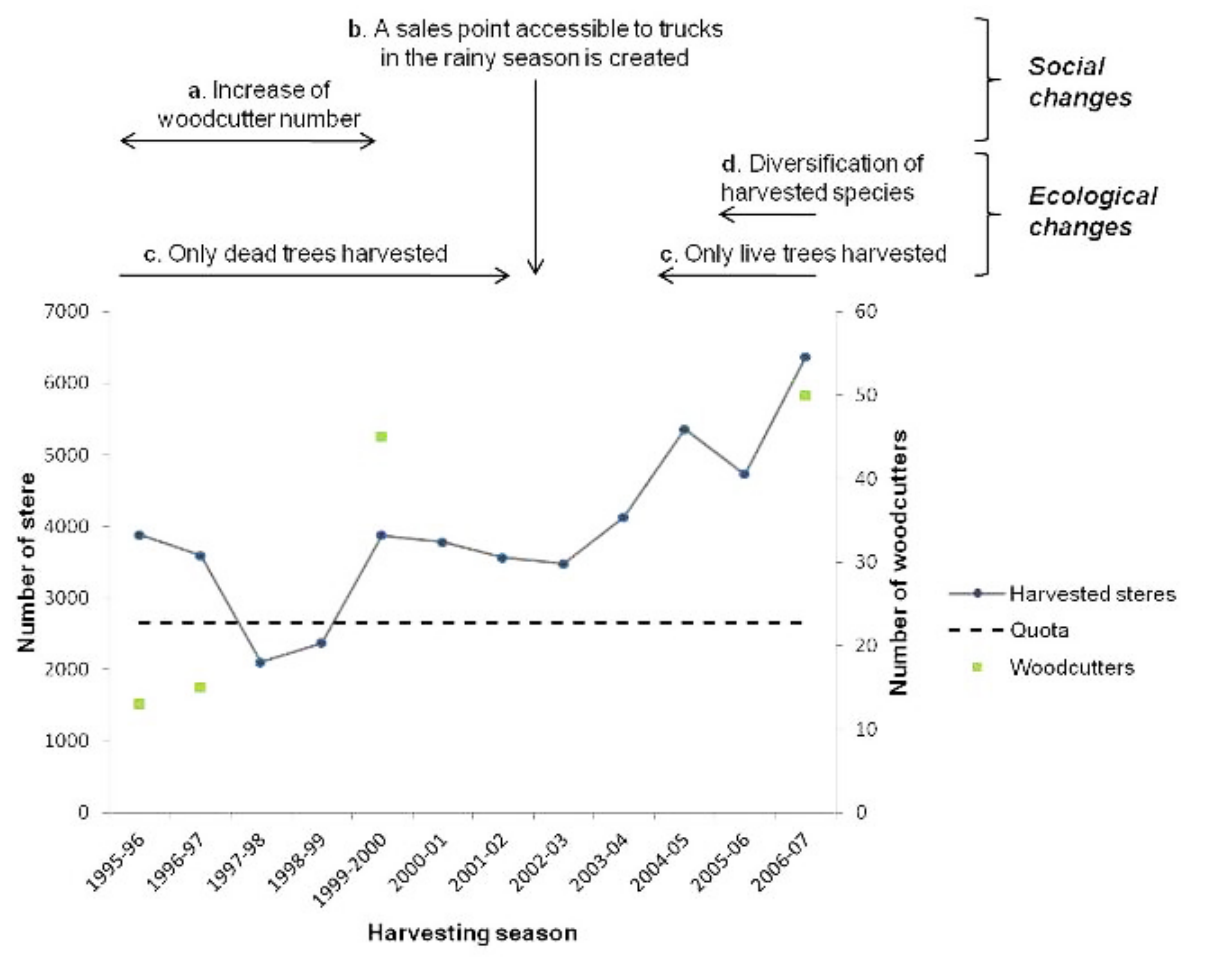
Fig. 4 . Changes in the Ñinpelima rural firewood market from 1995 to 2007 (source: LSM ledger and